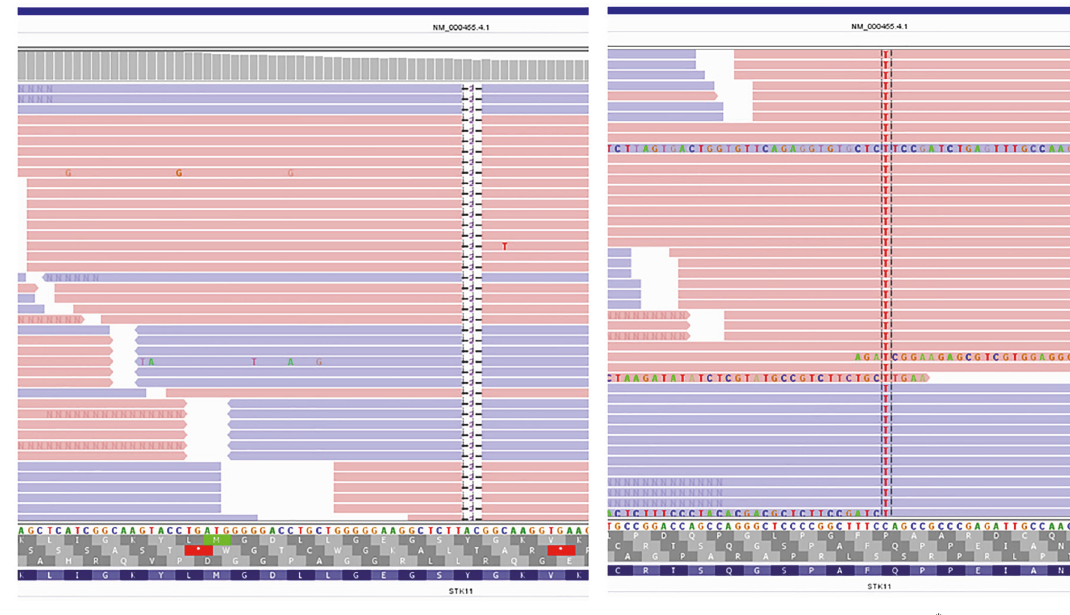
Figure 3: Visualization of two STK11 mutations in Integrative Genomics Viewer